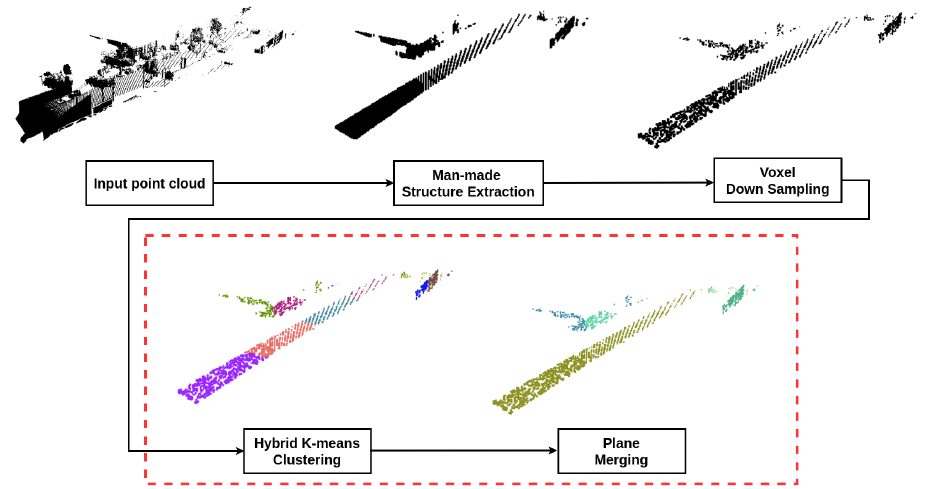
Figure 1. The plane segmentation procedure using the proposed system. We extract man-made